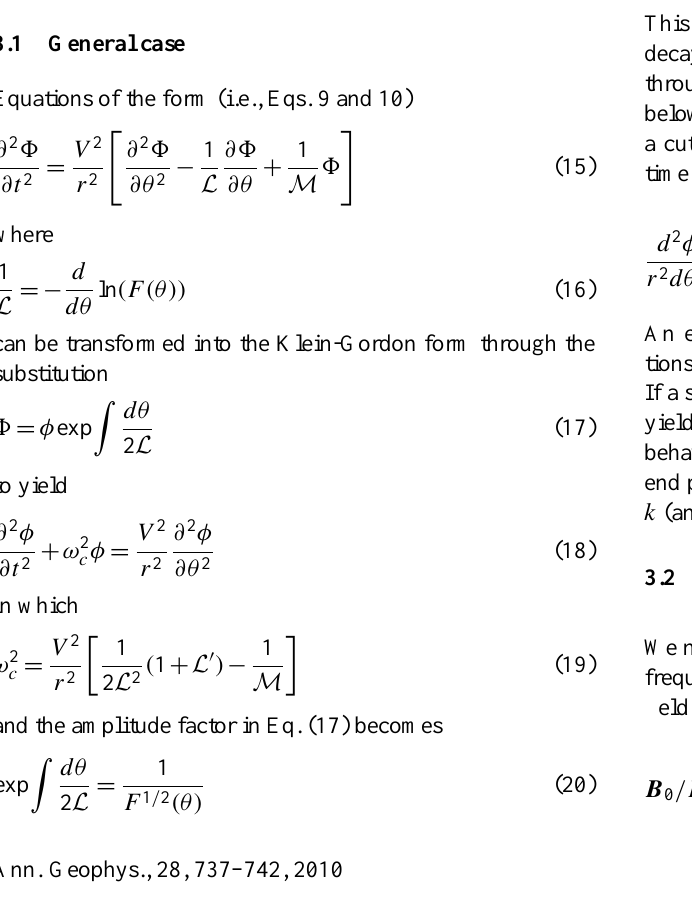
Fig. 6. Solution of the KG equation for L = 4 ,p = 3: 3rd harmonic. 3 The Klein-Gordon form